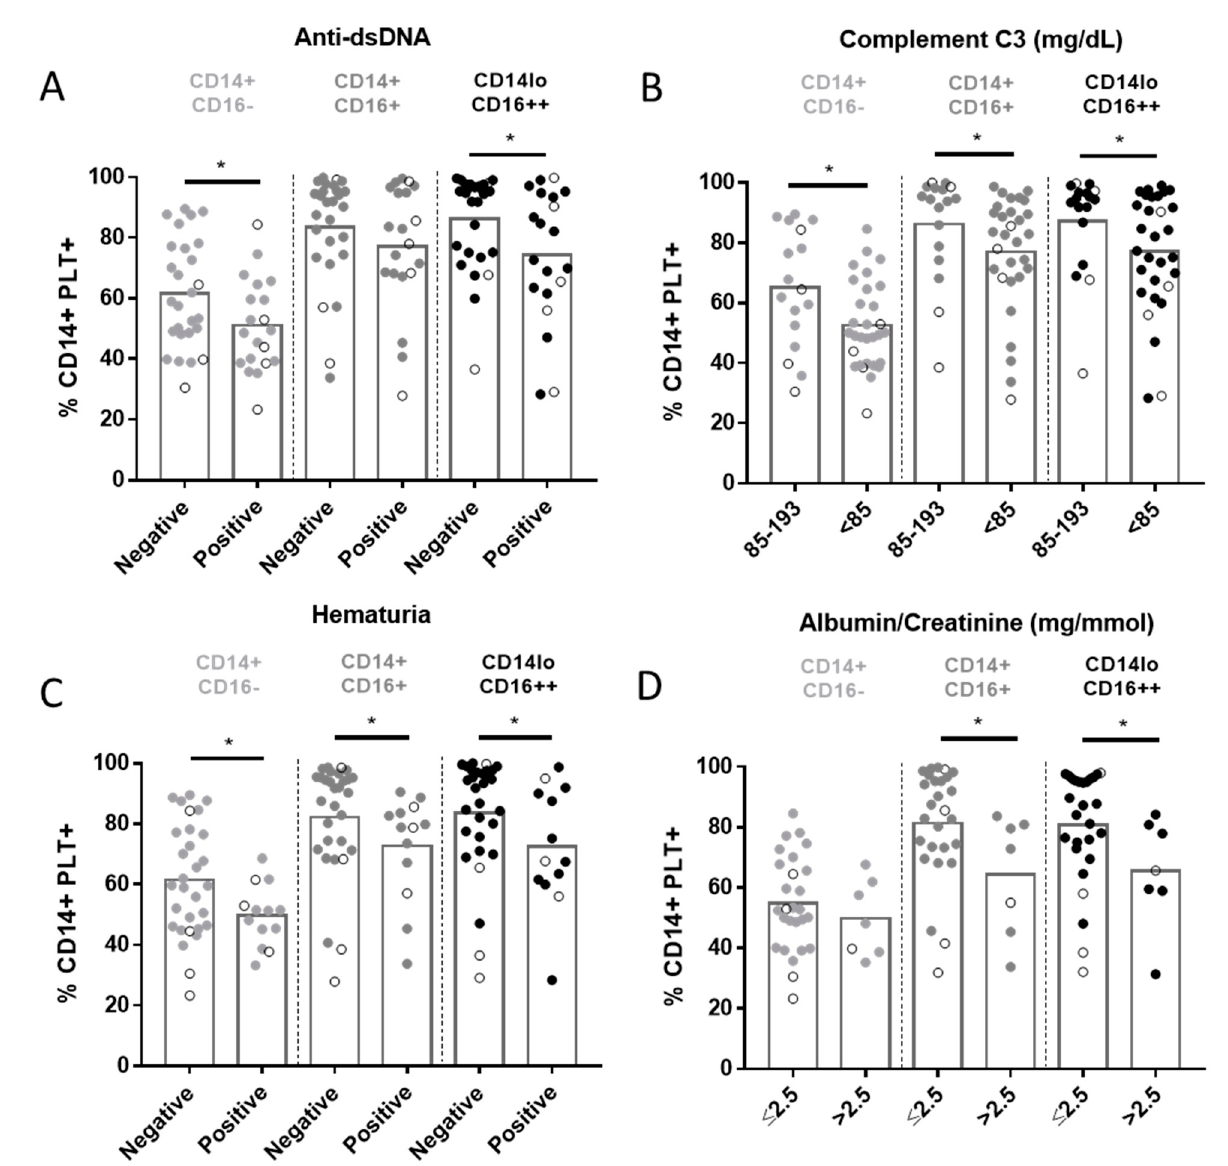
Figure 6. Percentage of monocyte subsets with bound platelets in SLE patients and clinical features. Comparisons of the percentages of monocyte subsets with bound platelets (CD14+PLT+) in SLE patients segregated according to ( A ) positive or negative anti-dsDNA, ( B ) <85 or 85–193 mg/dL of C3, ( C ) positive or negative hematuria and ( D ) >2.5 or ≤ 2.5 mg/mmol of albumin/creatinine are shown ( n = 49). Patients undergoing treatment with mycophenolate are marked with white circles. The statistical analysis was performed using the unpaired t -test. * p < 0.05.